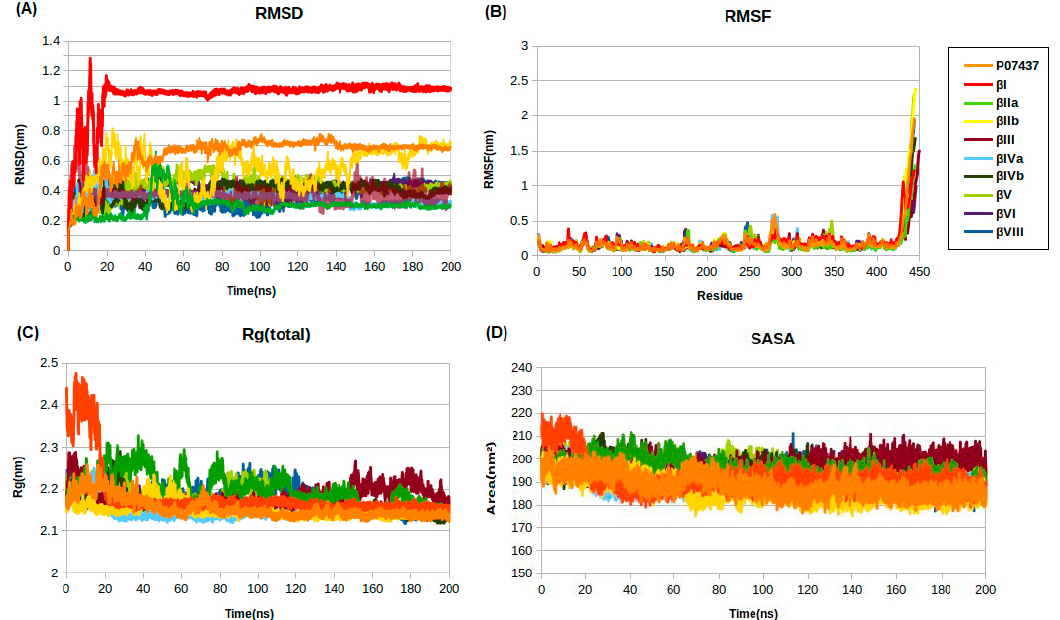
Figure 4. Structural dynamics of β -tubulin isotypes in complex with compound G1. ( A ) Root-mean- square deviation (RMSD), ( B ) root-mean-square fluctuations (RMSF), ( C ) radius of gyration (Rg), and ( D ), solvent-accessible surface area (SASA). P07437 corresponds to β -tubulin protein without ligand. Table 5. The average of RMSD, RMSF, Rg, and SASA for nine distinct β -tubulin isotypes during the last 20 ns of MD simulations.